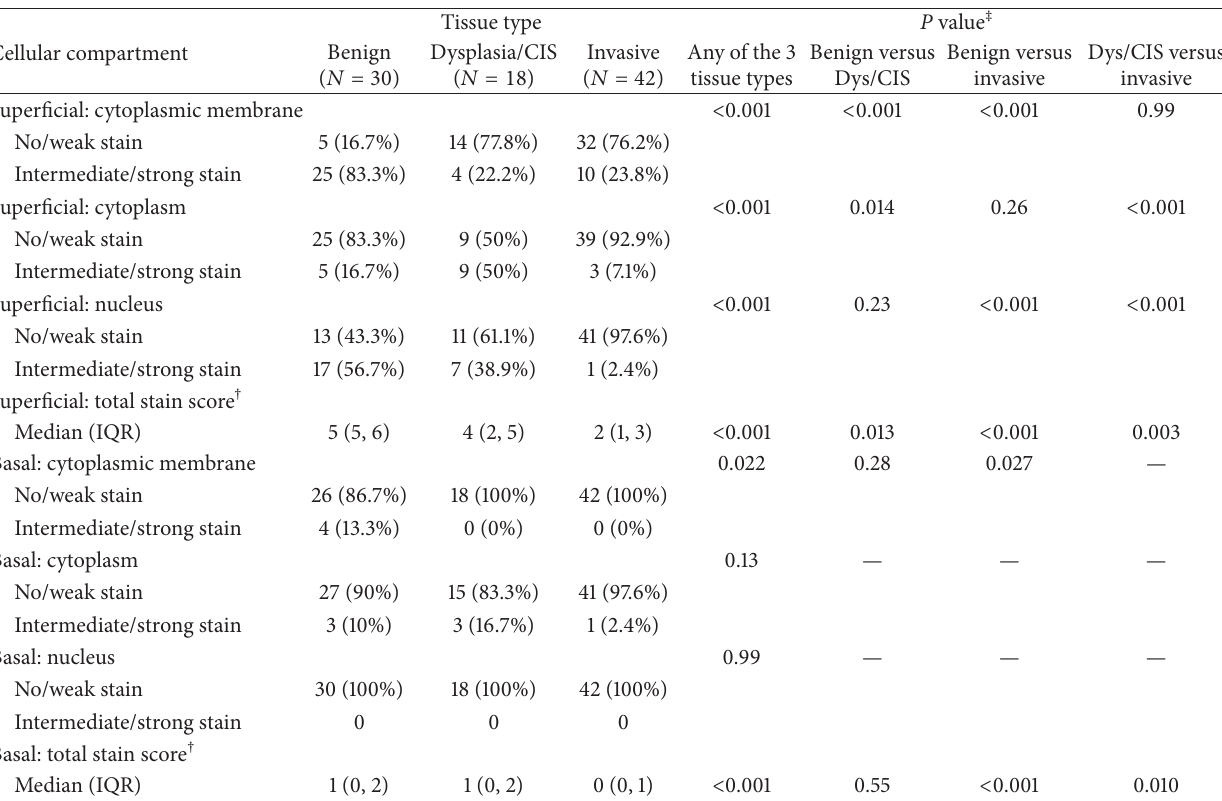
Table 1: Summary of staining results, by tissue